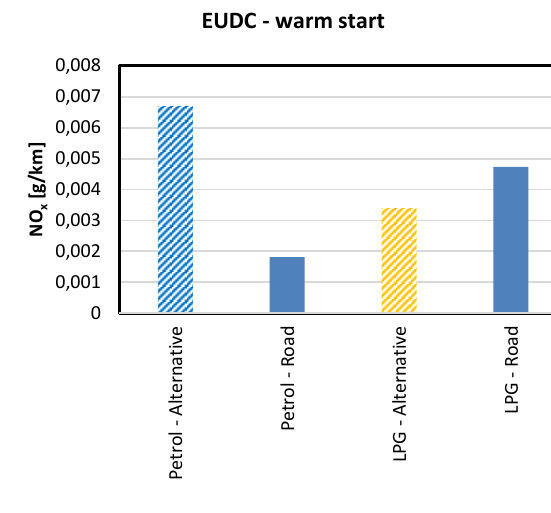
Fig. 14. Impact of resistance forces on NO x emissions for EUDC